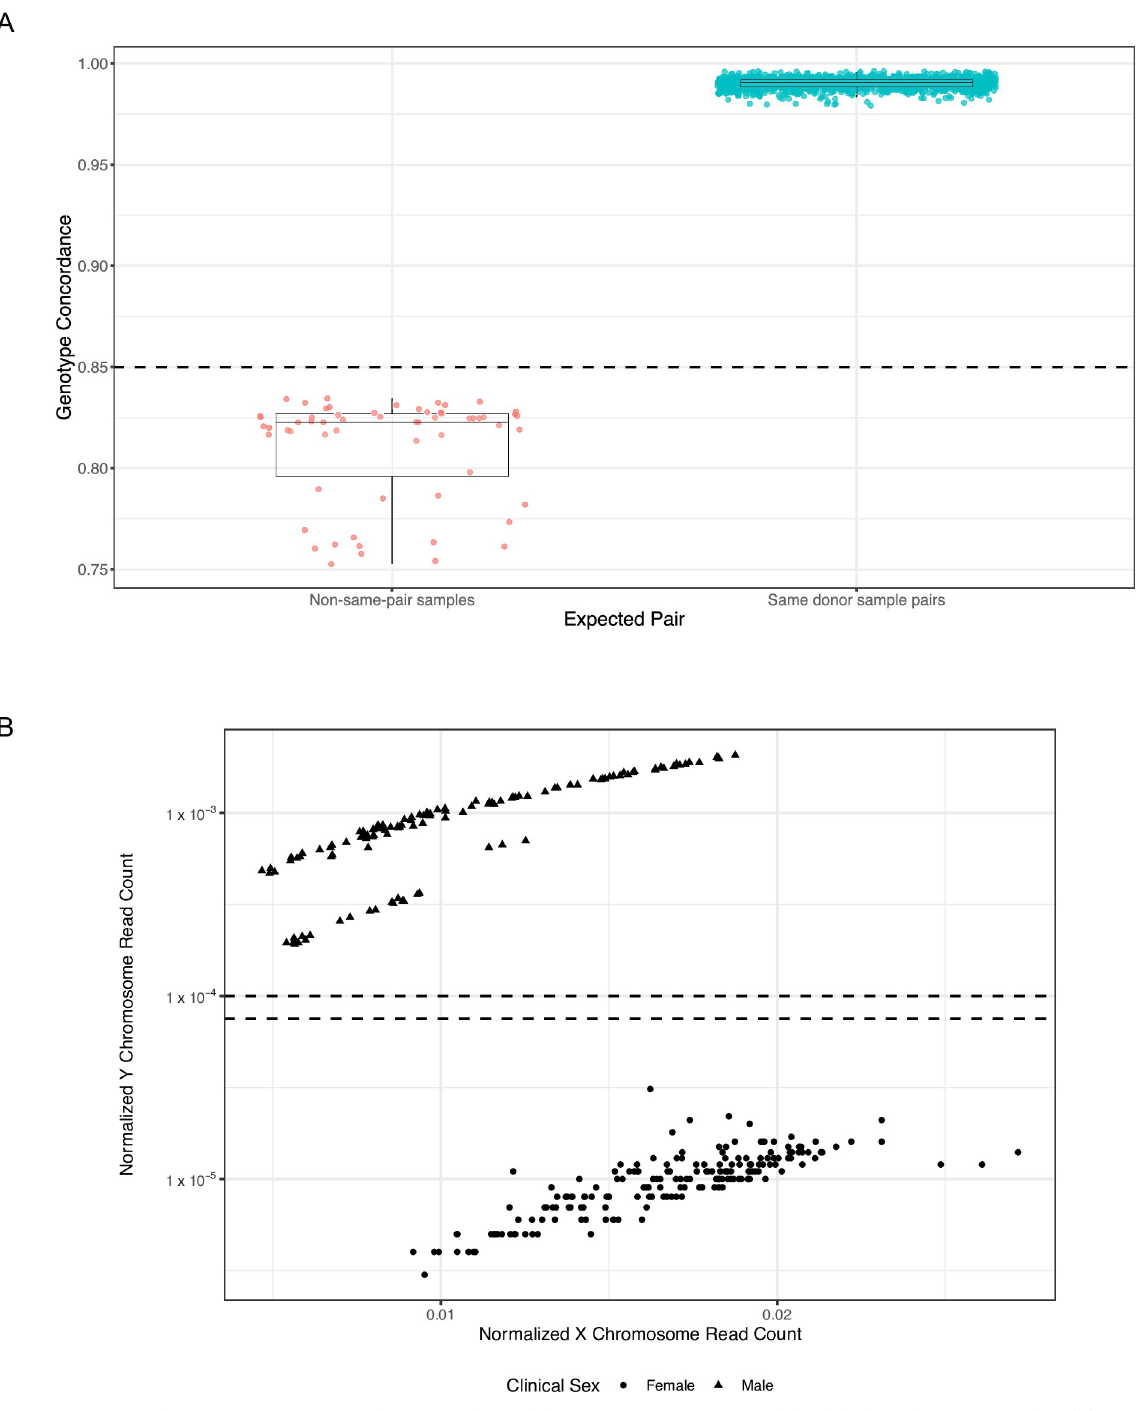
Fig 6. Assessment of cross contamination in plasma samples with the cross-contamination module of the bioinformatics pipeline. (A) Concordance of single-nucleotide polymorphism genotypes in same-donor sample pairs (teal circles) and non–same-pair samples (red circles). The horizontal dotted line indicates the threshold of 85% concordance used to call samples as not concordant (swapped) or concordant (not swapped). Boxes indicate 25th and 75th percentiles and the line inside corresponds to the median. Whiskers extend to minimum and maximum values, excluding outliers. Data points have been slightly offset horizontally (jittered) to better visualize points that may otherwise overlap. (B) Sex calls analysis. Male (triangles) and female (circles) samples were differentiated by the proportion of X and Y chromosome sequencing reads (x- and y-axes, respectively). The horizontal dotted lines indicate the thresholds used to call samples as male or female.